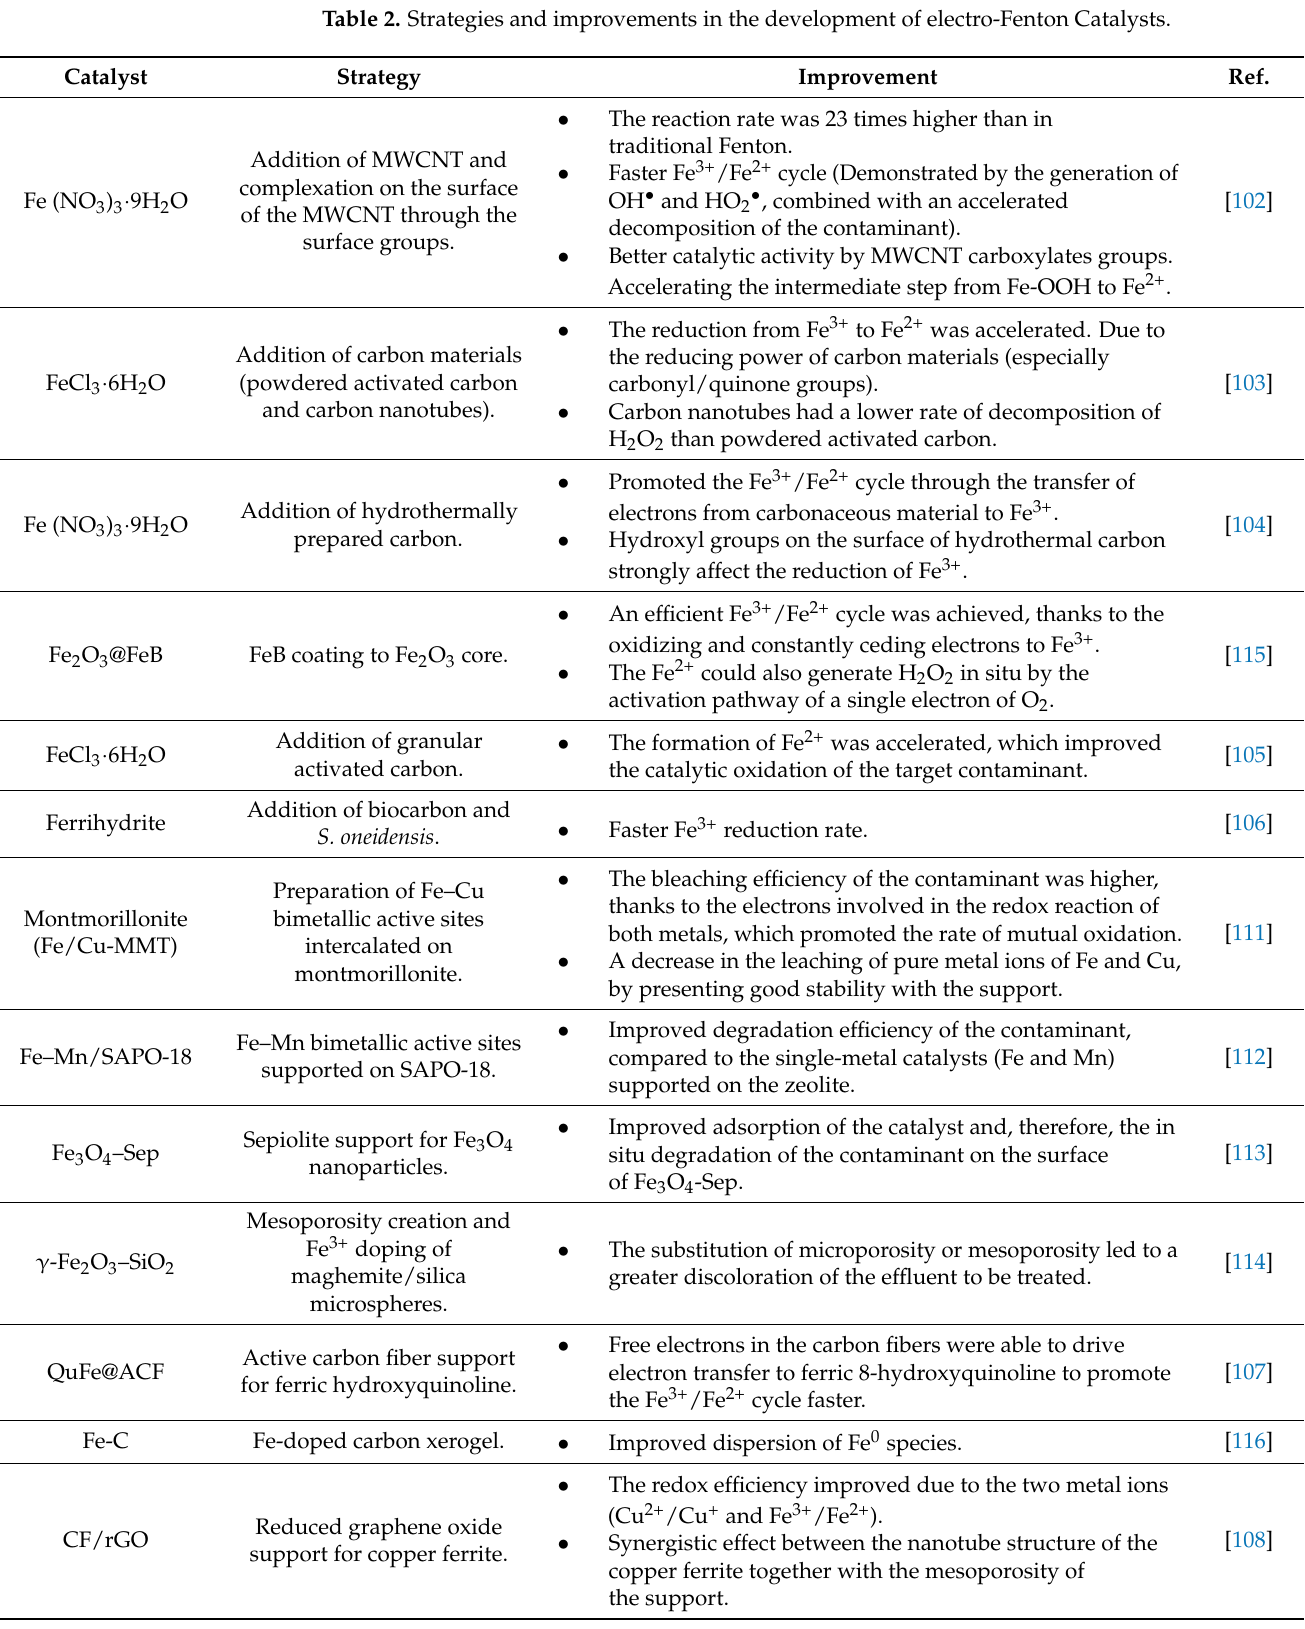
Table 2. Strategies and improvements in the development of electro-Fenton